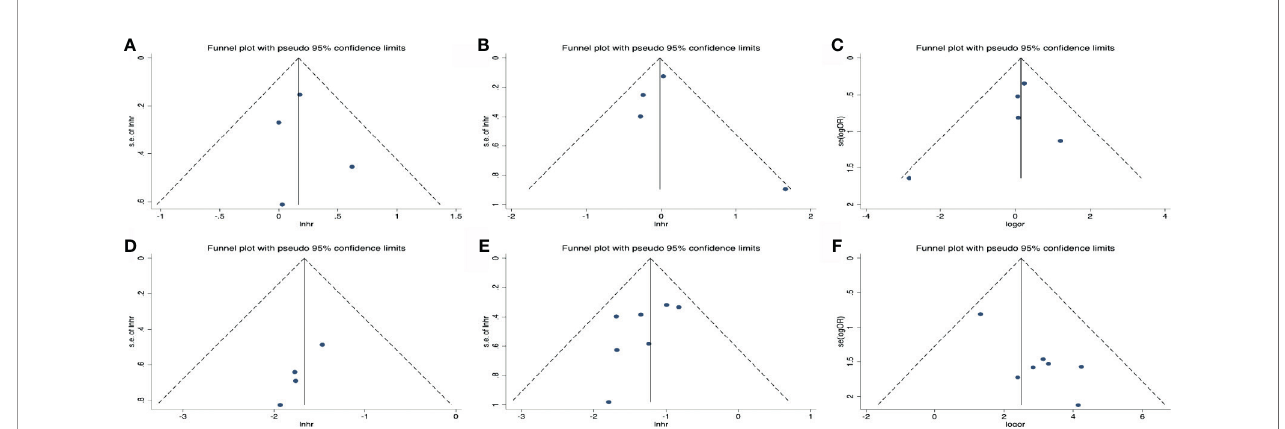
FIGURE 6 | Publication bias for the association of detected baseline ctDNA with (A) overall survival, (B) progression-free survival, (C) objective response rate and (D) the relationship of early decreased ctDNA with OS; (E) PFS;